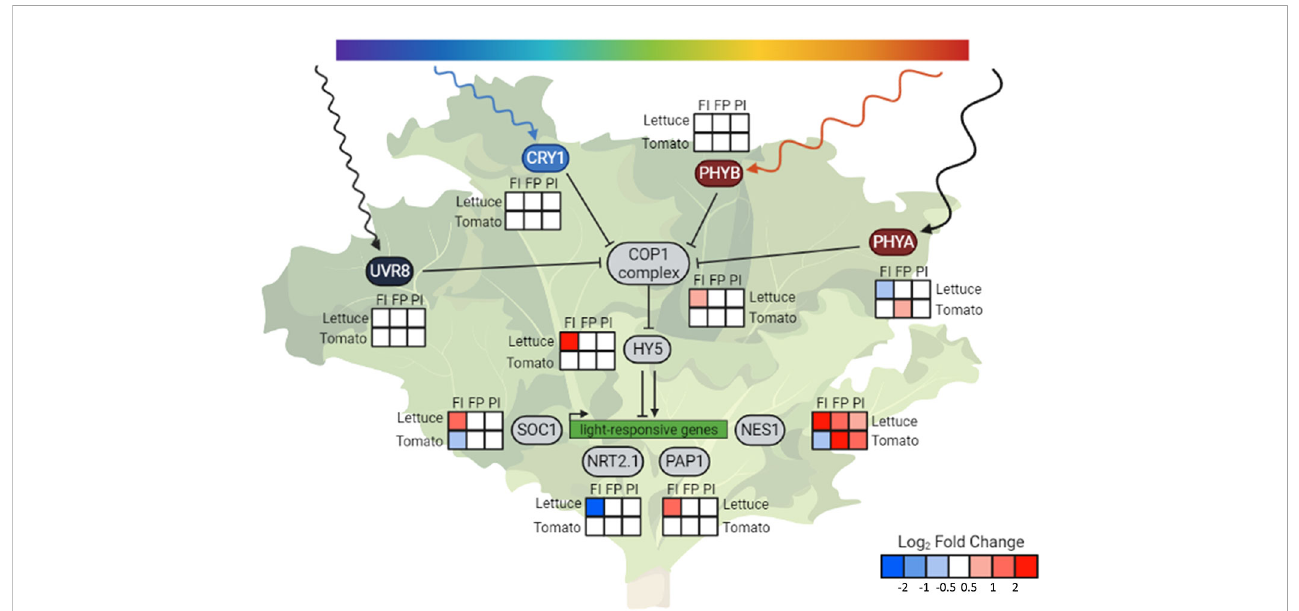
FIGURE 9 HY5 integrates light signals and regulates downstream genes. Condensed photoreceptor signaling pathway with expression of downstream genes of interest in lettuce and tomato. The photoreceptors indirectly upregulate expression of HY5 through inhibition of the constitutive photomorphogenic 1 (COP1) complex formation. Elongated hypocotyl 5 (HY5-1) is a transcription factor that is a known or hypothesized regulator of many light-responsive genes, including suppressor of overexpression of CO 1 ( SOC1 ), high af fi nity nitrate transporter 2.1 ( NRT2.1-1 ), production of anthocyanin pigment1/ MYB75 ( PAP1 ) and (3S,6E)-nerolidol synthase 1 ( NES1-1 ). COP1 itself was differentially expressed in response to light quality changes in lettuce but not tomato. The changes in COP1 expression are in the opposite direction of many of the trends observed in phyA1 expression, indicating gene-level regulation of this gene. Despite a lack of differential expression of COP1 and HY5 , expression of downstream genes, such as NES1 , were altered in tomato, indicating another method of light regulation. Relative transcript abundance is represented by log 2 fold changes between speci fi ed treatments. Created with